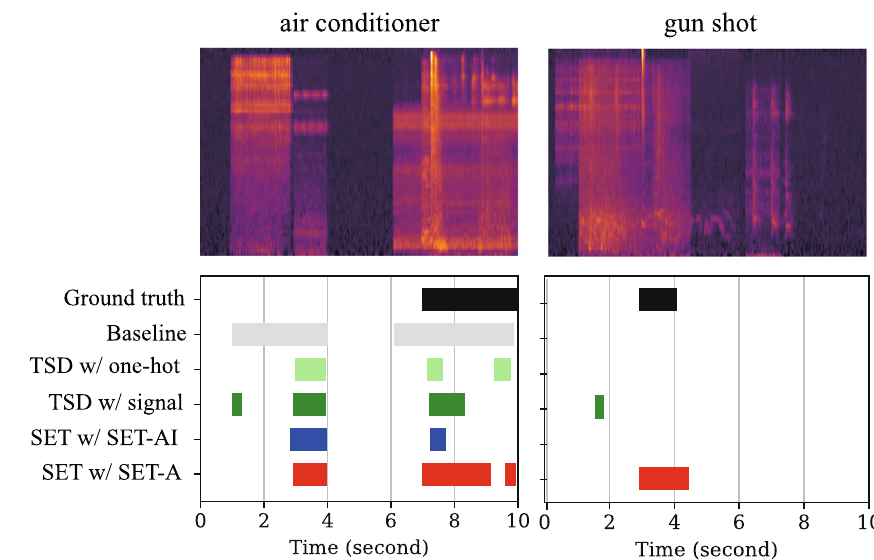
Fig. 11 Examples of detection results for each